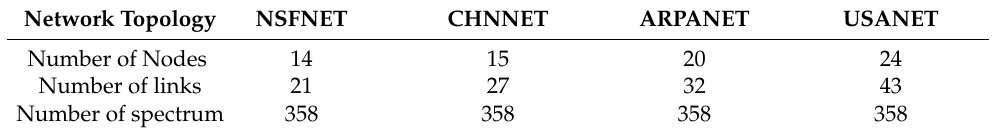
Table 1. Parameters for four types of